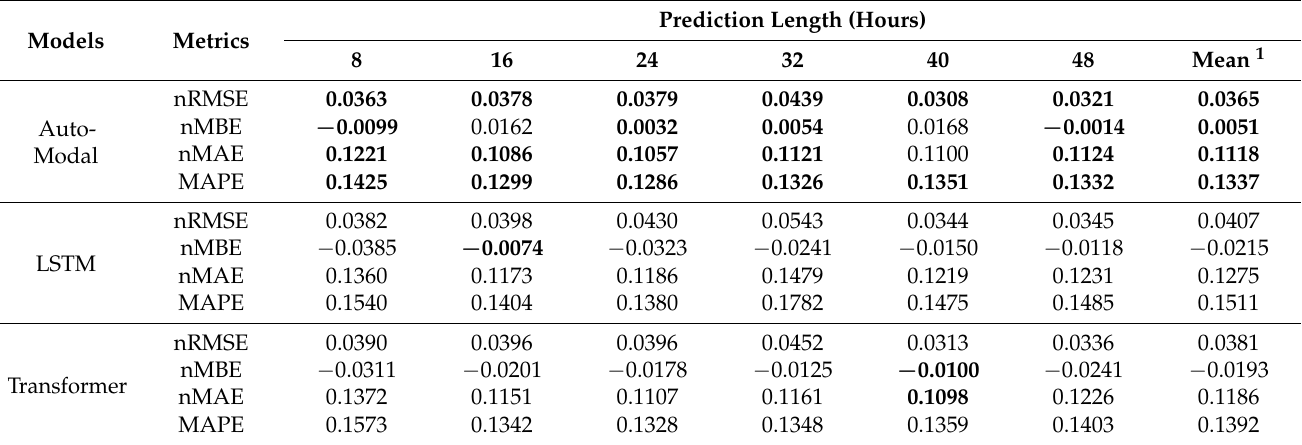
Table 3. Metrics of the auto-modal and NLP models with different prediction